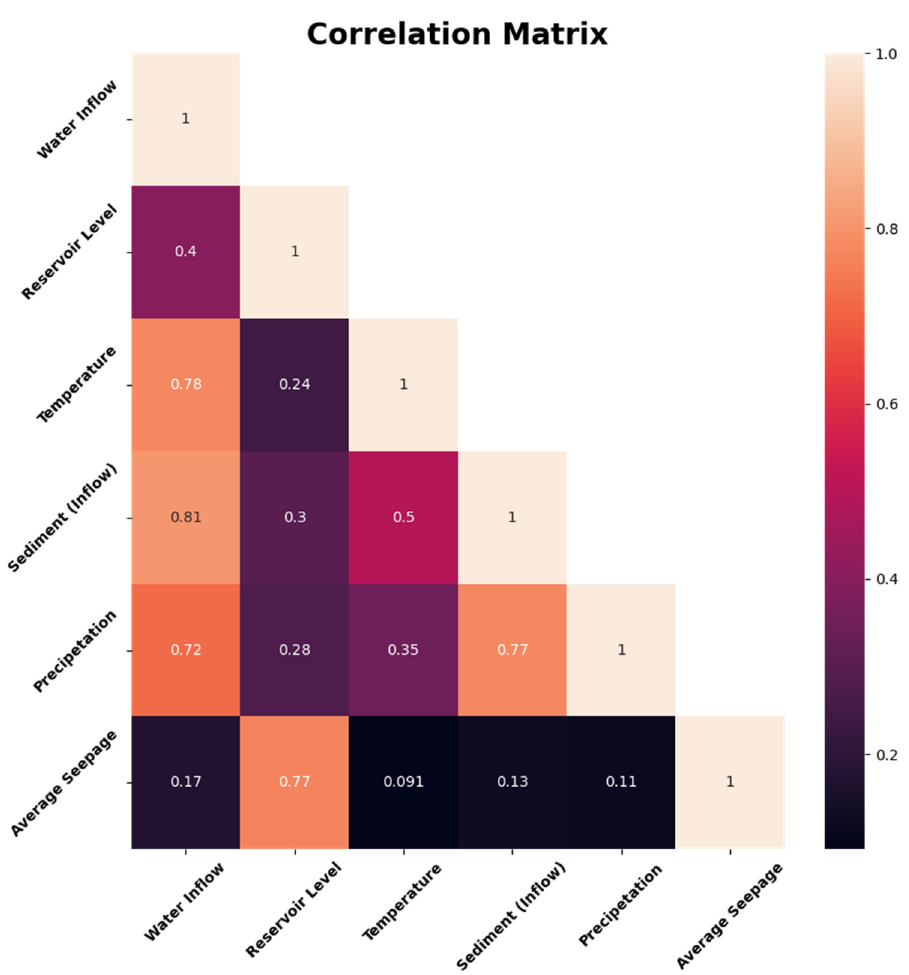
Figure 6. Correlation Matrix for hydro-Metrological variables.